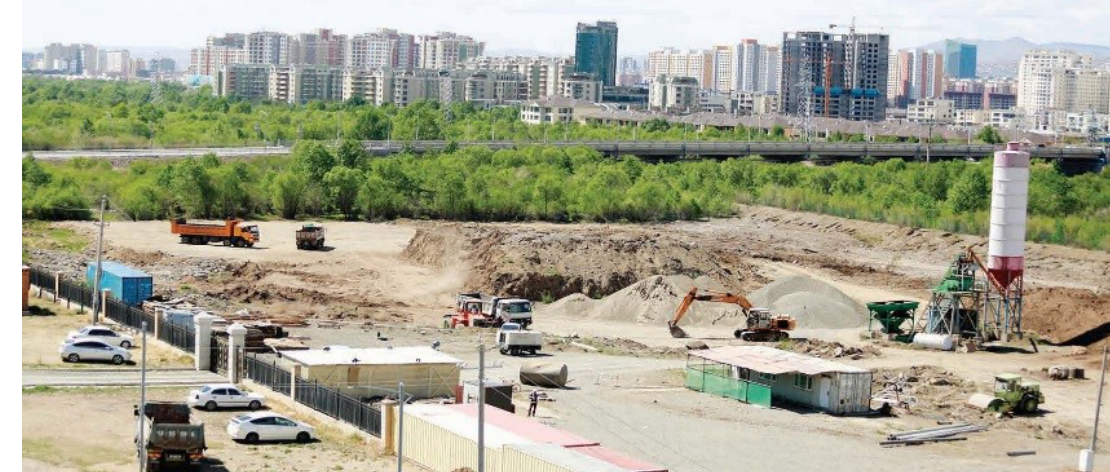
Figure 4. Floodplain erosion of Tuul River